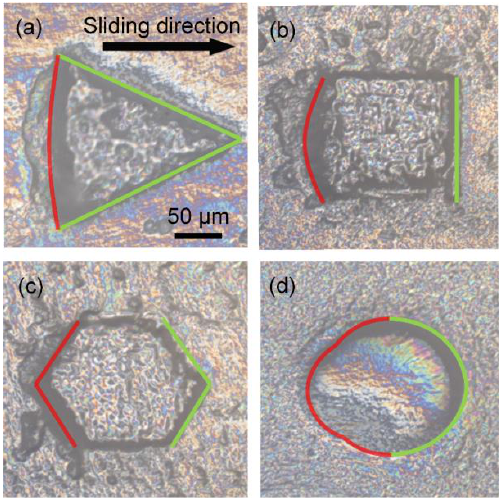
Figure 5. Confocal images of wear. ( a ) Triangle. ( b ) Square. ( c ) Hexagon. ( d ) Circle. The green curve is the leading edge. The red curve is the trailing edge.